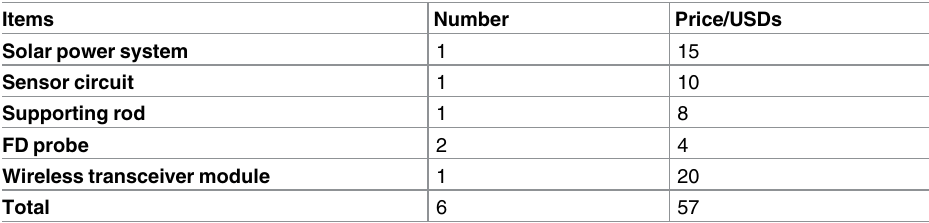
Table 1. Cost details of